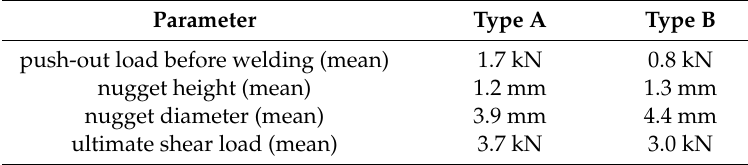
Table 3. Mechanical properties of joints and geometric sizes of weld